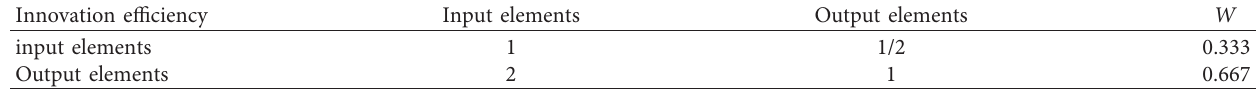
Table 1: Judgment matrix of primary indicators of knowledge supply chain.